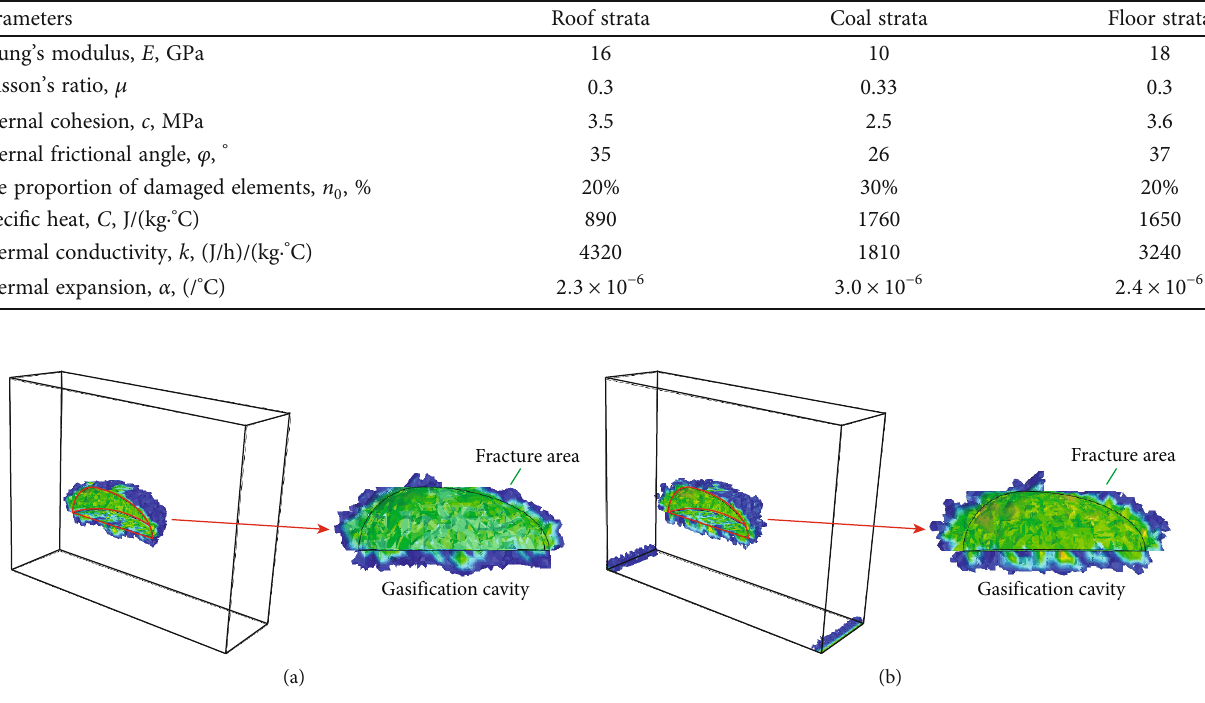
Figure 3: The fracture evolution law of surrounding rock in the combustion cavity: (a) condition 1 and (b) condition